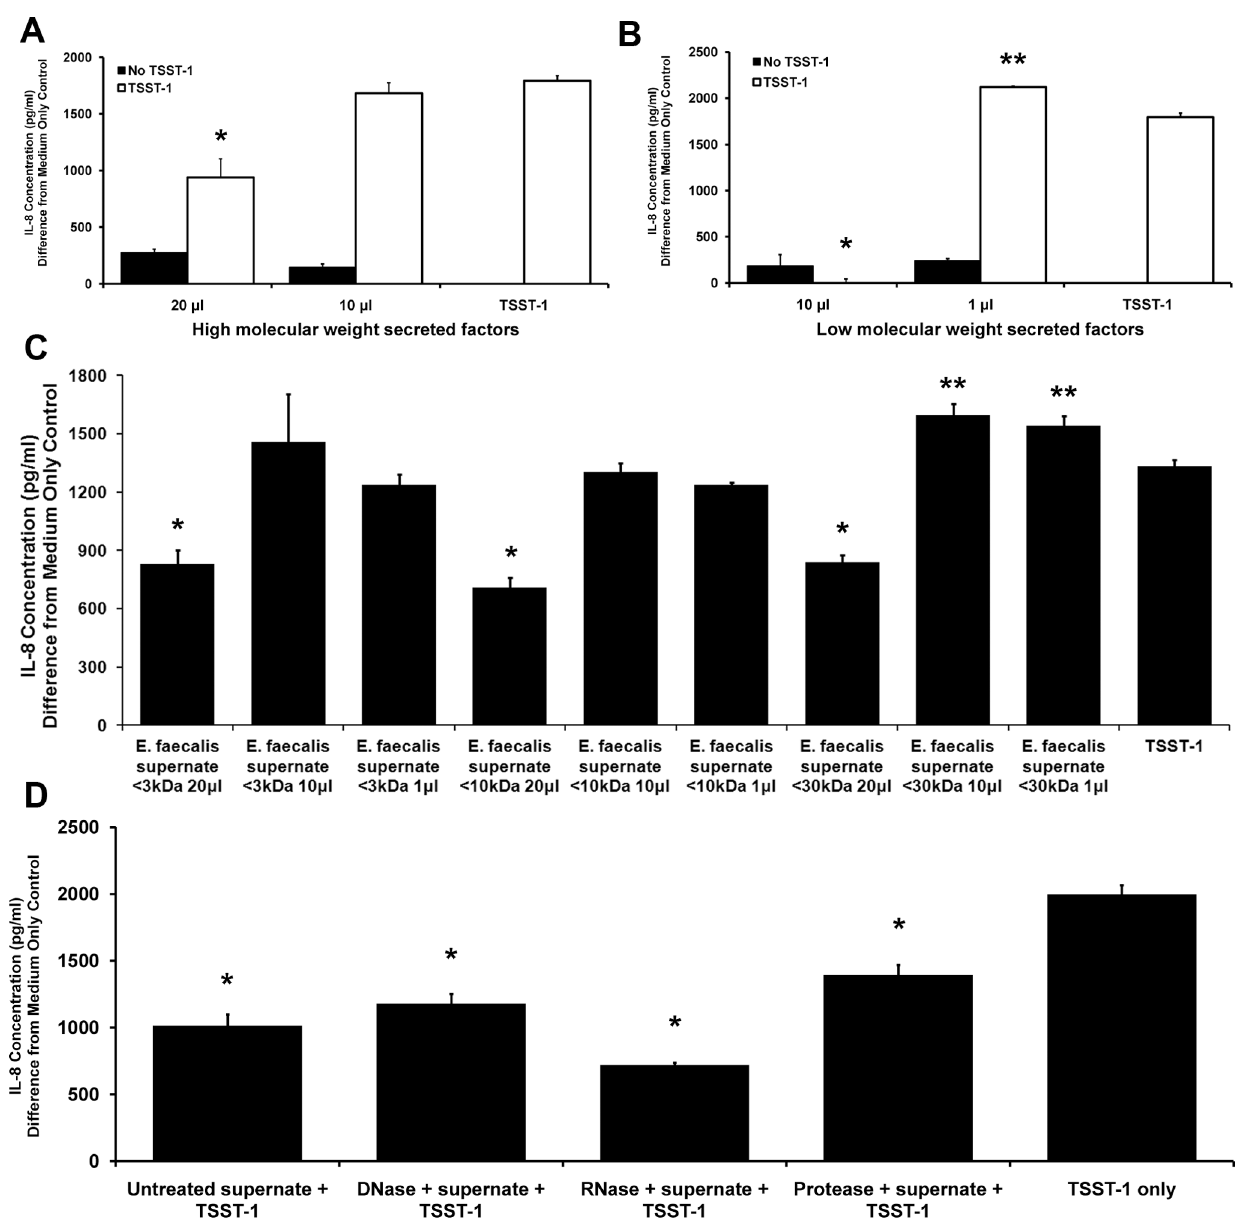
Figure 6. E.faecalis MN1 secretes a small molecule responsible for inhibition of TSST-1-induced IL-8 production by HVECs. A) Eighty percent ethanol was used to precipitate high molecular weight factors from filter-sterilized E. faecalis MN1 supernate. Isolated factors were added to HVECs 6 TSST-1 (100 m g/ml) for 6 h, and IL-8 was measured by ELISA. Only the 20 m l condition showed inhibition of TSST-1-induced IL-8 by Student’s t test (p , 0.001). B) Low molecular weight (unprecipitated) factors were concentrated by lyophilization, resuspended in PBS to the same concentration as the precipitated material, and incubated with cells as described above. Lower doses of unprecipitated material were used to minimize cytotoxicity to the HVECs. The 10 m l condition showed absolute inhibition of IL-8 production (*p , 0.001), whereas the 1 m l condition actually enhanced IL-8 levels in response to TSST-1 (**p , 0.001) by individual Student’s t tests. These results are based on the average of two separate experiments, each containing three replicates per condition. C) Filter-sterilized E. faecalis MN1 supernate was separated into different molecular weight fractions using Microcon centrifugal filters and incubated with HVECs + / 2 TSST-1 (100 m g/ml) for 6 h. Inhibition of TSST-1-induced IL-8 production is maintained in all fractions ( , 3 kDa, , 10 kDa, , 30 kDa) when the cells were incubated with 20 m l of material (*p , 0.005); a higher level of IL-8 was detected when cells were incubated with smaller amounts of the , 30 kDa fraction (**p , 0.05) by individual Student’s t tests. These data are from a single experiment carried out in triplicate. D) Filter-sterilized E. faecalis MN1 supernate was treated with DNase, RNase, or protease prior to incubation with TSST-1 (100 m g/ml) on HVECs for 6 h. None of the treatments affected the ability of the secreted factor to inhibit TSST-1-induced IL-8 production from the cells by individual Student’s t tests (*p , 0.001). These data are the average of two experiments, each done in triplicate. the TSST-1 only control. After growth of E. faecalis MN1 in beef molecular weight, ethanol soluble fraction was lyophilized and heart medium, higher molecular weight material was removed by concentrated 480 6 relative to the original culture. Dilutions of the precipitation with 80% final concentration ethanol. The low fraction (48 6 to 0.00048 6 ) were evaluated for effects on TSST-1-